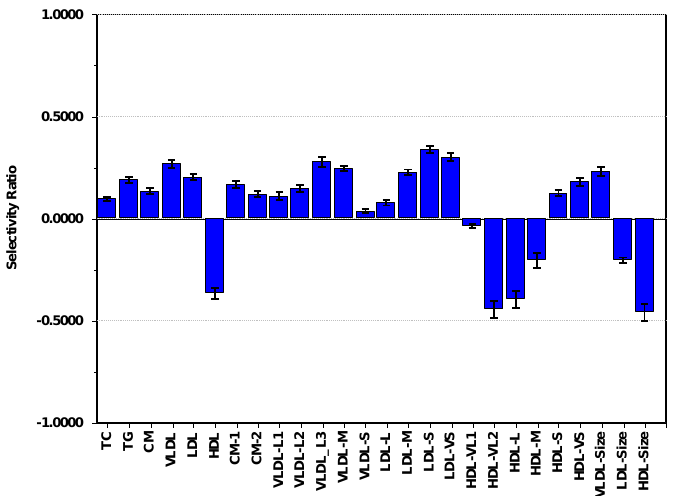
Figure 6. Selectivity ratio plot of a regression model with the adiposity PC1 score as outcome (R2Y = 0.260) and the lipoproteins, adjusted for age, sex, and physical activity, as explanatory variables.